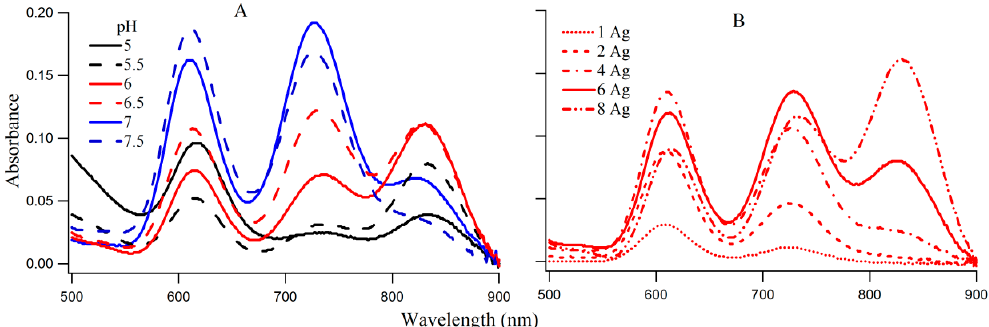
Figure 4. (A ) Absorption spectra of silver nanoclusters on 3T4G template (15 μ M DNA and 90 μ M AgNO 3 and 90 μ M NaBH 4 ) in 10 mM citrate buffers of pH 5, 5.5, 6, 6.5, 7, and 7.5; ( B ) Influence of increasing [Ag] on the absorption spectra of 3T4G templated Ag-NCs in buffer of pH 6.5. Species I, II, III correspond to the absorption bands at ~620, 730, 830 nm.